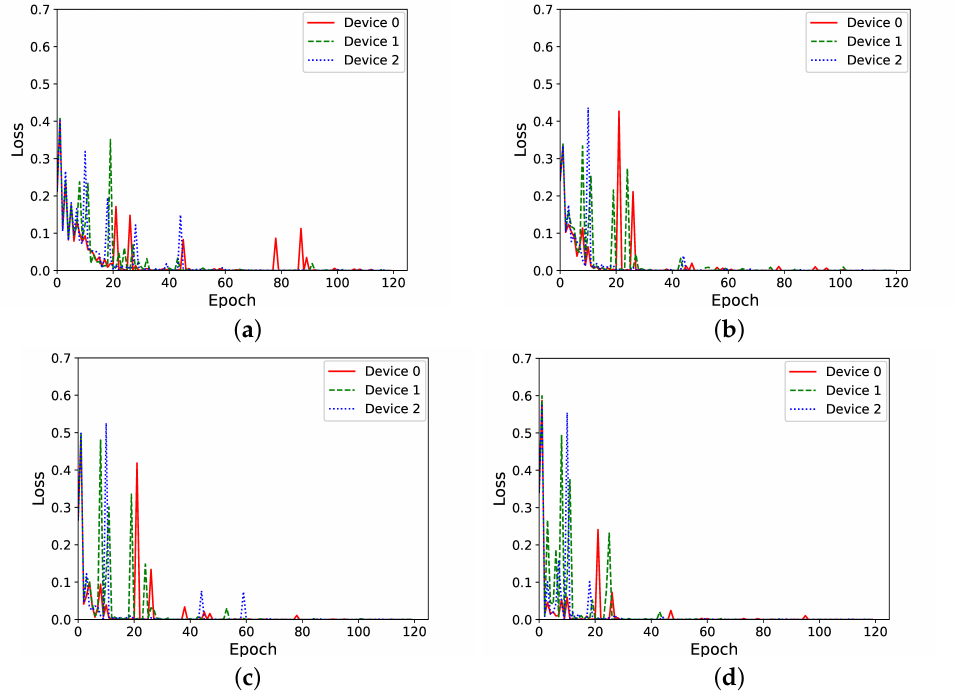
Figure 7. Loss vs. epochs during training for different hidden layer sizes. ( a ) Hidden layer of 5 neurons. ( b ) Hidden layer of 10 neurons. ( c ) Hidden layer of 20 neurons. ( d ) Hidden layer of 25